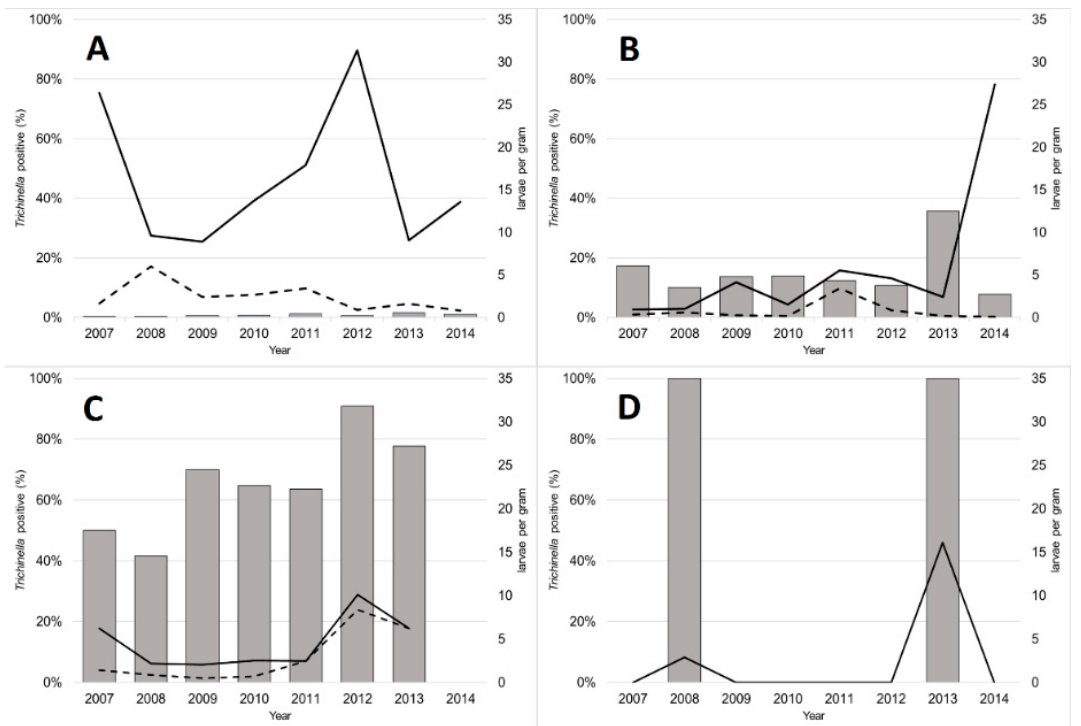
Figure 1. Percentage of Trichinella spp. positive animals; Mean (solid line) and median (dashed line) number of larvae per gram tissue in tested wild boars ( Sus scrofa , A ), brown bears ( Ursus arctos , B ), Eurasian lynxes ( Lynx lynx , C ) and badgers ( Meles meles , D ), 2007–2014, Estonia.